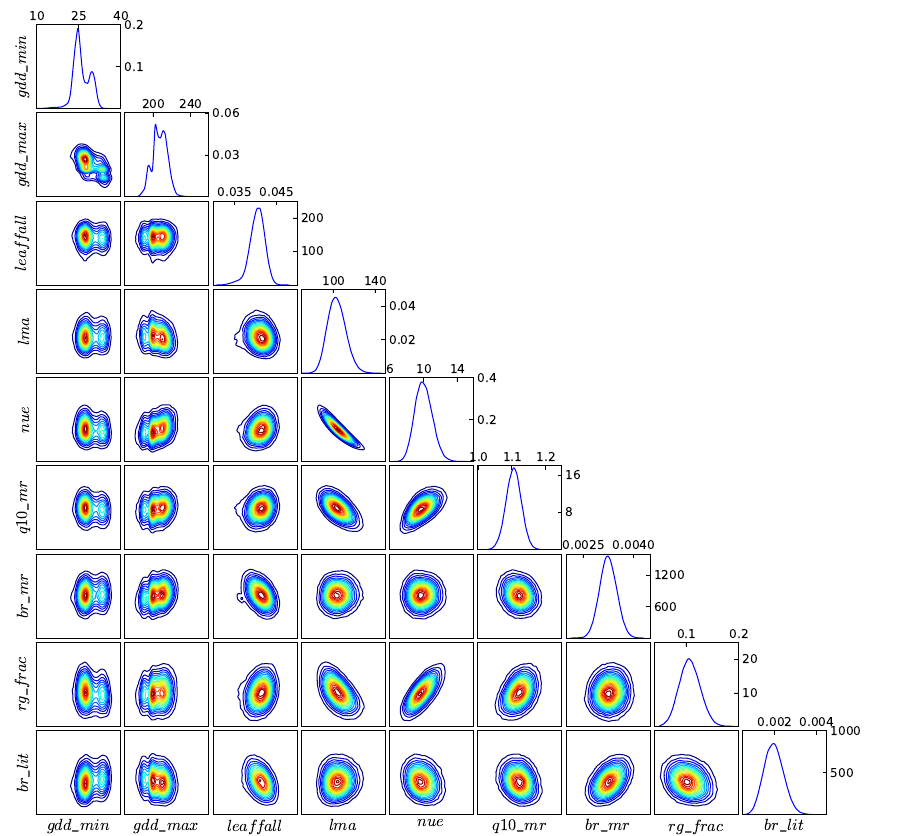
Figure 13. D ST problem: 1-D marginal and 2-D joint marginal probability density functions (PDFs) for parameters showing distance corre- lation factors above 0.4; see also Table 3. Marginal PDFs are estimated via KDE based on approximately 4 × 10 5 MCMC samples.